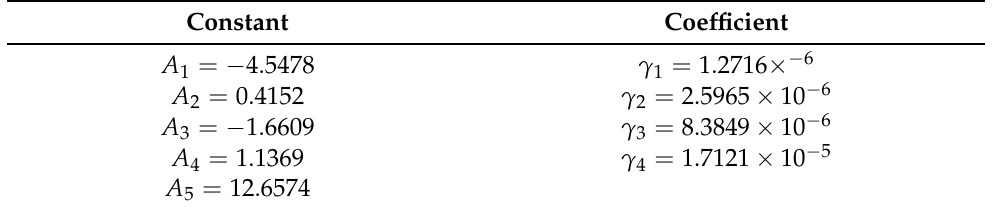
Table 3. Coefficients and constants for partial fractional expansion (19) of the fractional-order approximation